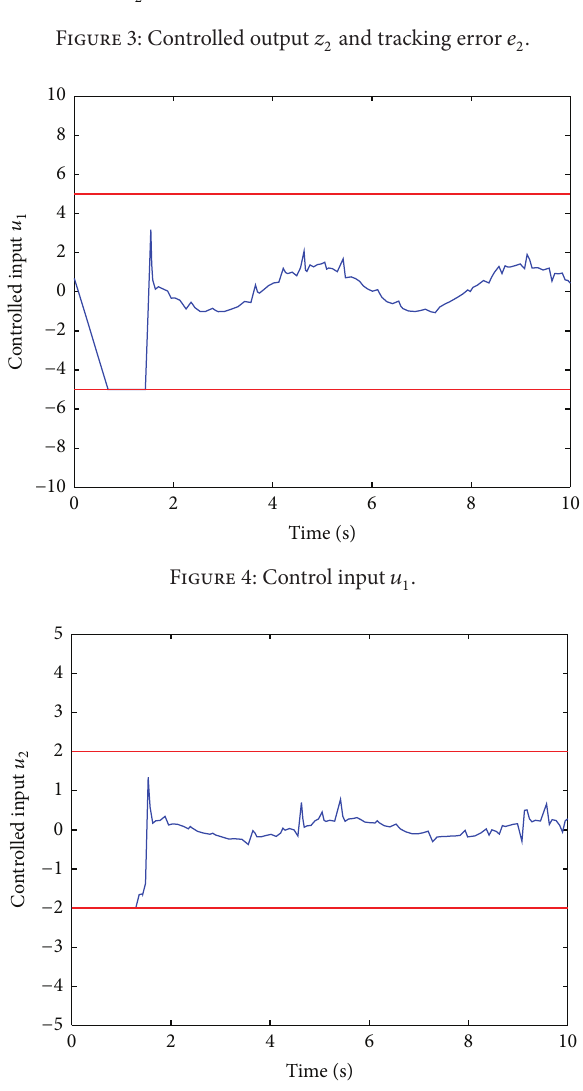
Figure 5: Control input 𝑢 2